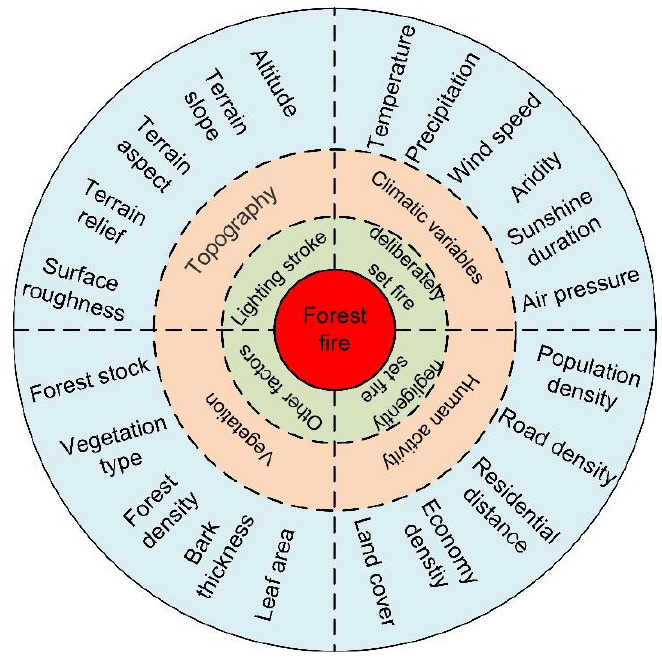
Figure 2. The main driving forces of wildfire.